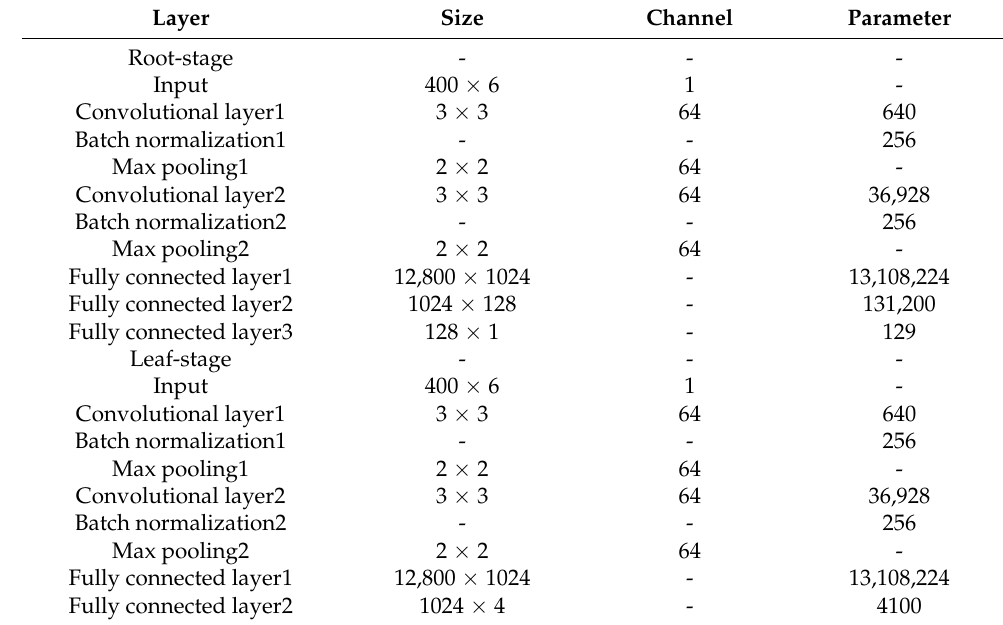
Figure 4. The pipeline of the proposed zero-shot collision localization method. Table 3. The structure of the proposed RL-CNN.